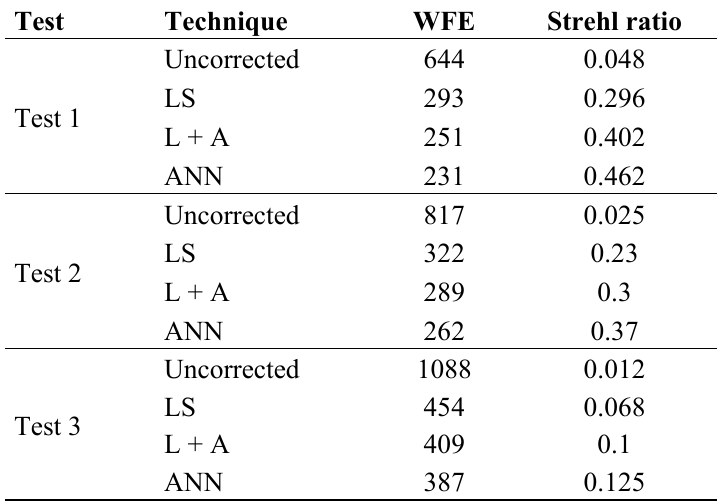
Table 4. Test results with the three reconstruction techniques.